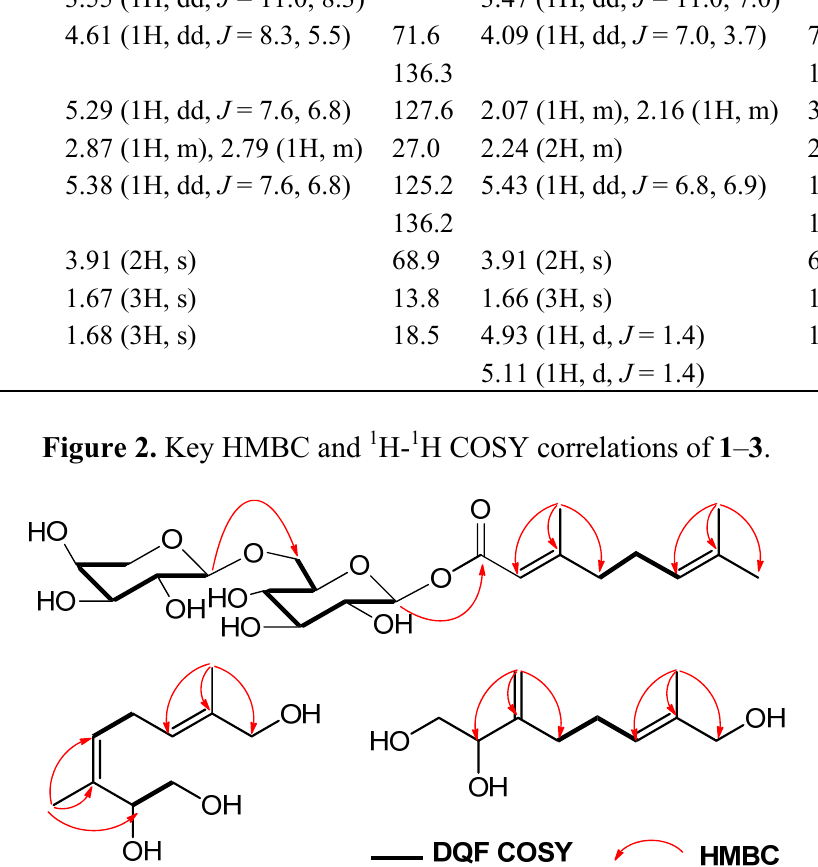
Table 2. 1 H- and 13 C-NMR data for 2 and 3 (600 and 150 MHz, CD